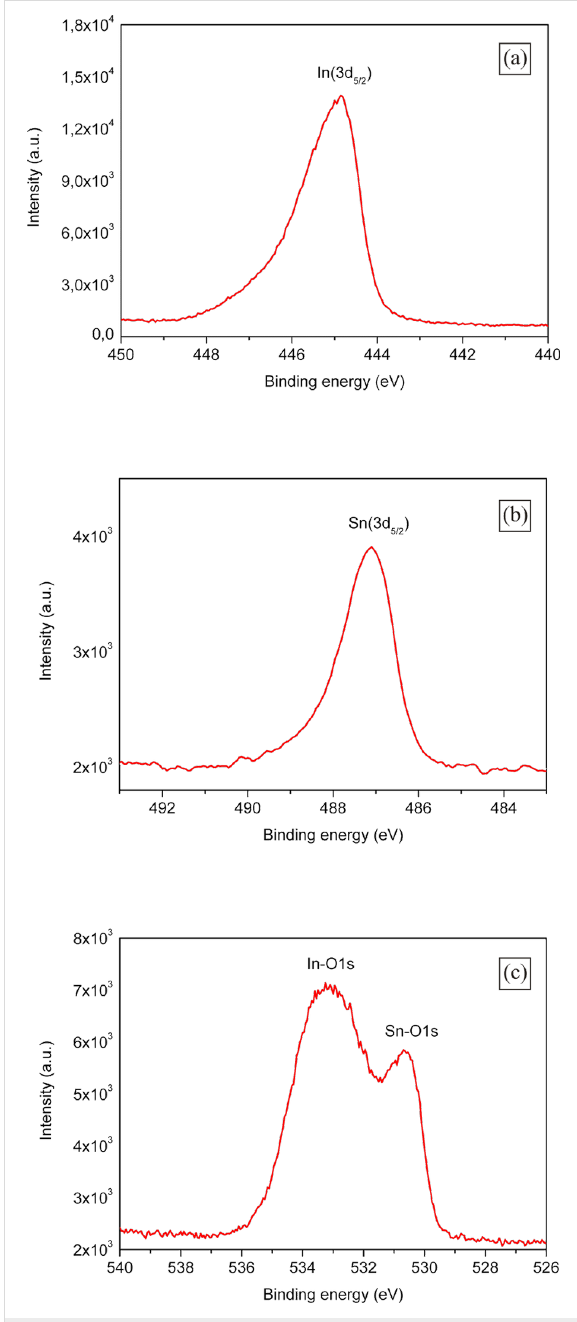
Figure 4: XPS spectra of the synthesized ITO-NTs (a) In(3d) spec- trum; (b) Sn(3d) spectrum; (c) In-O(1s) and Sn-O(1s)